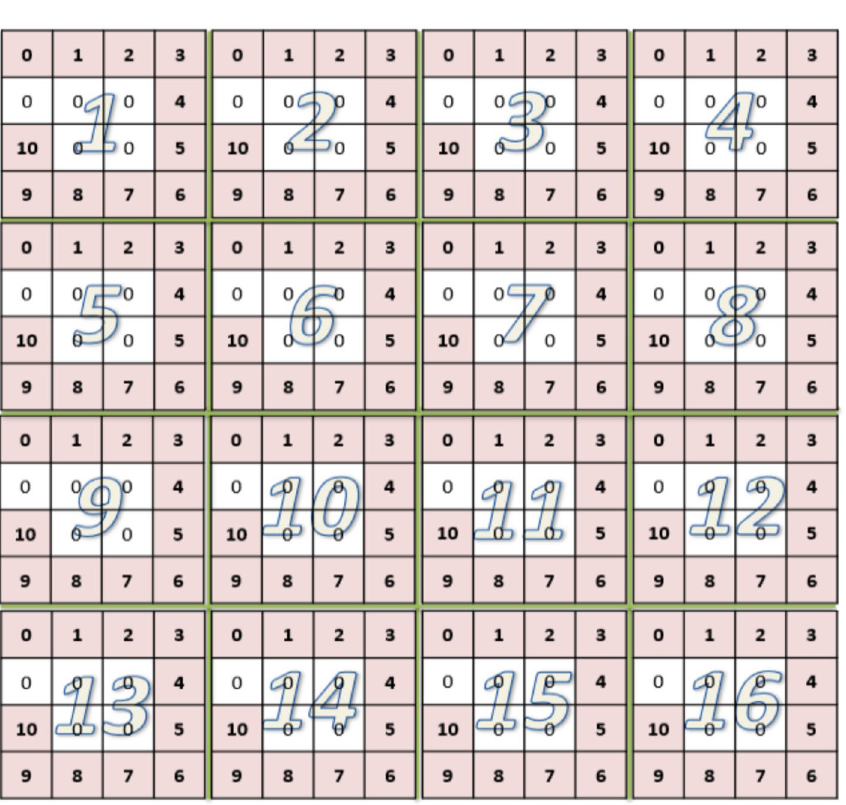
Figure 6. 16 4*4 data grids arranged sequentially one after another to form a Mosaic data structure as the network input to keep the time feature of the original